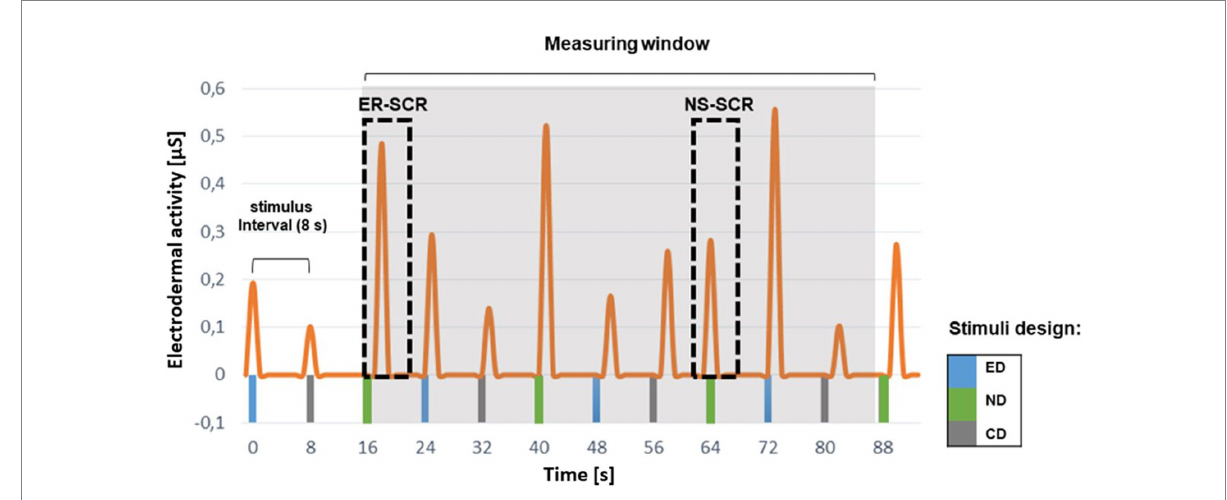
FIGURE 5 Exemplary skin conductance response (SCR) signals for set 2. The measurement window comprises nine stimuli (3× emotional [ED], 3× neutral [ND], and 3× control design [CD]). Each stimulus is being viewed for 8 s. A signal which occurred within the chosen response window (1–3 s) is rated as an event-related SCR signal (ER-SCR). In contrast, a signal that occurred outside the response window is considered a non-specific SCR signal